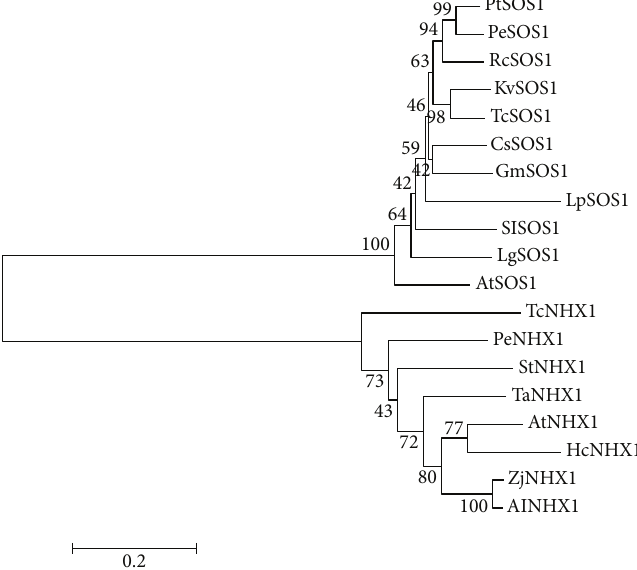
Figure 4: Phylogeny of KvSOS1 and other Na + /H + antiporter proteins derived from Populus trichocarpa (PtSOS1, XP 002315837.2), Populus euphratica (PeSOS1, ABF60872.1), Ricinus communis (RcSOS1, XP 002521897.1), Theobroma cacao (TcSOS1, EOY01238.1), Citrus sinensis (CsSOS1, XP 006492282.1), Glycine max (GmSOS1, AFD64746.1), Lolium perenne (LpSOS1, AAY42598.1), Solanum lycopersicum (SlSOS1, NP 001234698.1), Limonium gmelinii (LgSOS1, ACF05808.1), Arabidopsis thaliana (AtSOS1, AF256224 1), Theobroma cacao (TcNHX1, XP 007030791.1), Populus euphratica (PeNHX1, ACZ05630.1), Solanum torvum (StNHX1, AEN04067.1), Triticum aestivum (TaNHX1,AAS17949.1), Arabidopsisthaliana (AtNHX1,NP 198067.1), Halostachyscaspica (HcNHX1,ADK62565.1), Zoysiajaponica (ZjNHX1, ABY19311.2), and Aeluropus littoralis (AlNHX1,